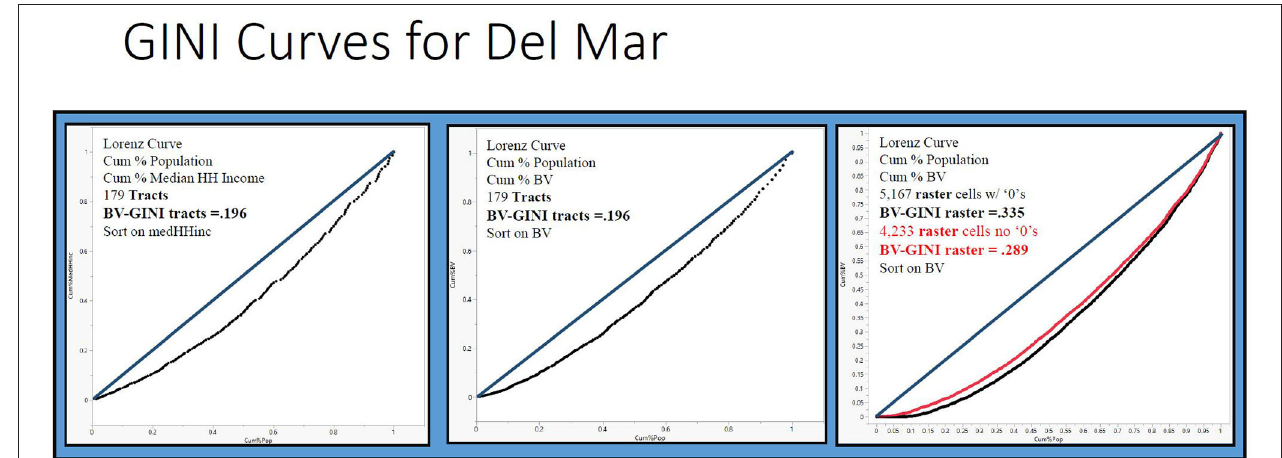
FIGURE 4 | Lorenz curves for raster and vector representations of Del Mar, California.